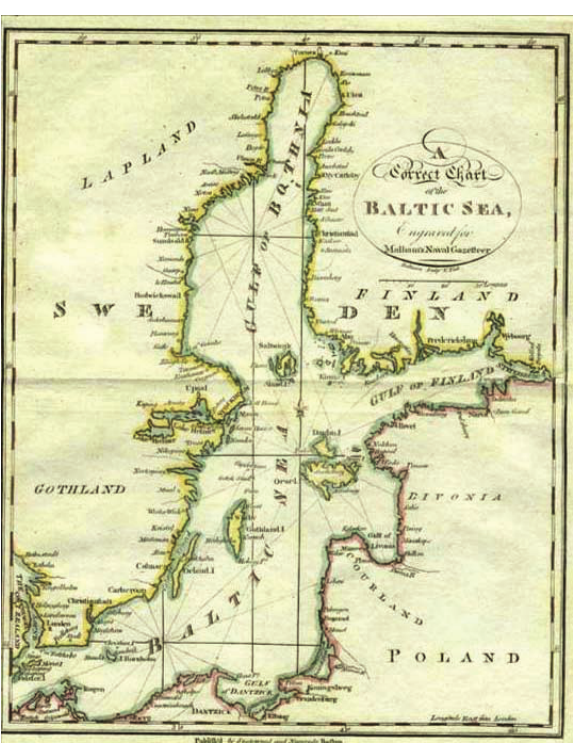
Fig. 7. Tablet sheets of riverbed Nemunas in the territory of Lithuania in 1896 and fragment of 179 sheet (j. Deksnys